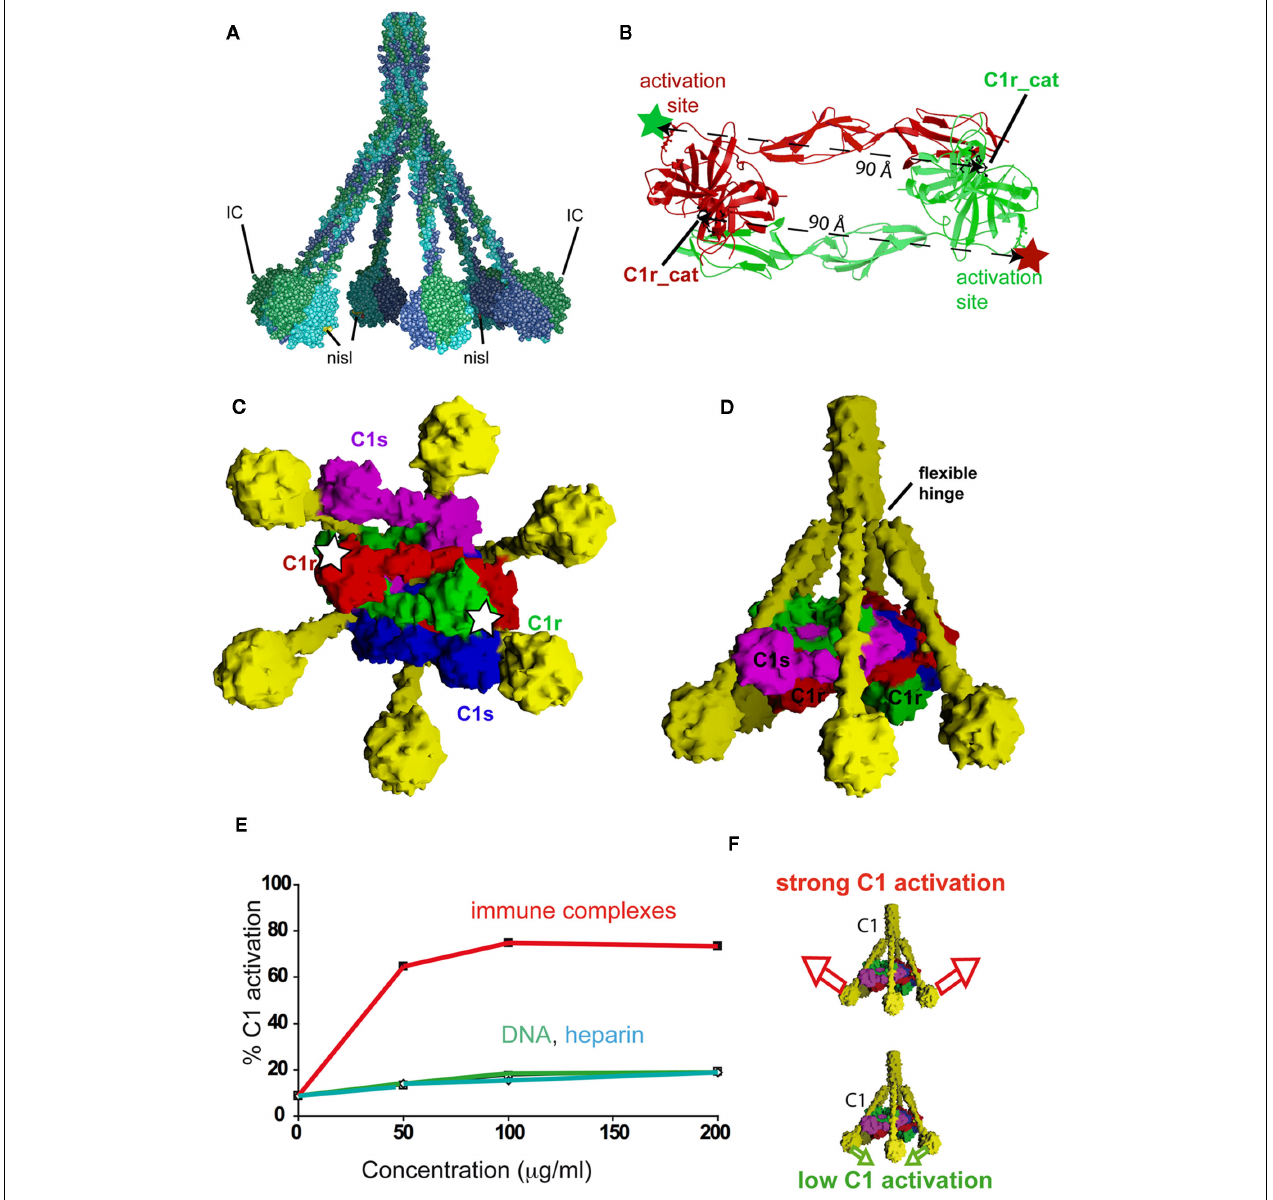
FIGURE 5 | Implications on C1 activation of the location of ligand-binding sites in the C1q globular domain. (A) Location of the ligand-binding sites according to the current version of the C1q model. Nisl: non-immune self ligands binding area as described in Figure 4 ; IC: proposed binding sites for IgG-containing immune complexes. (B) Dimeric structure of the C1r catalytic domain in its “resting state.” In this configuration, a distance of 90Å is observed between the catalytic site (C1r_cat) of one subunit and the activation site (colored star) to be